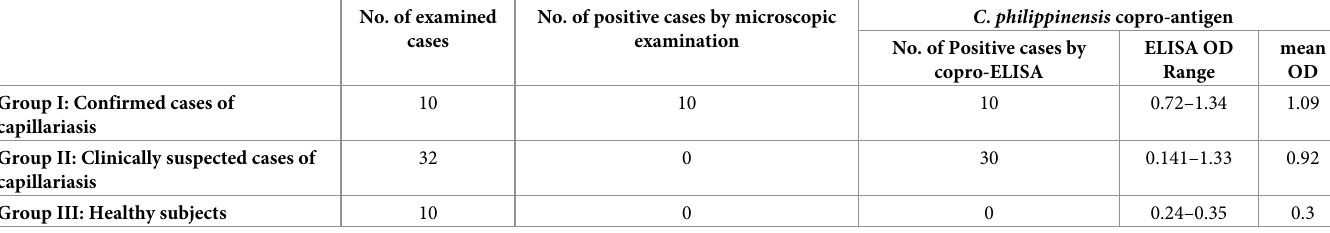
Table 2. Detection of C . philippinensis coproantigen in stool eluates of different study groups. No. of examined